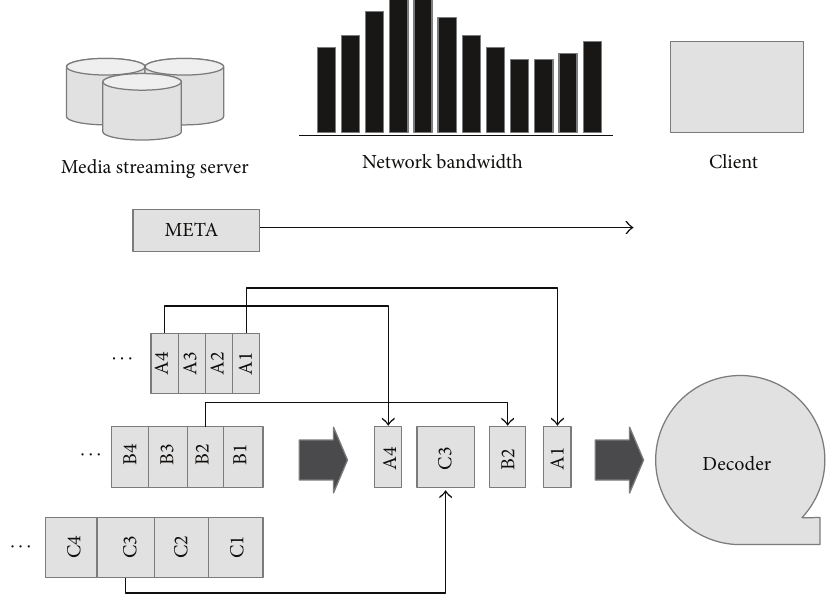
Figure 2: Adaptive streaming